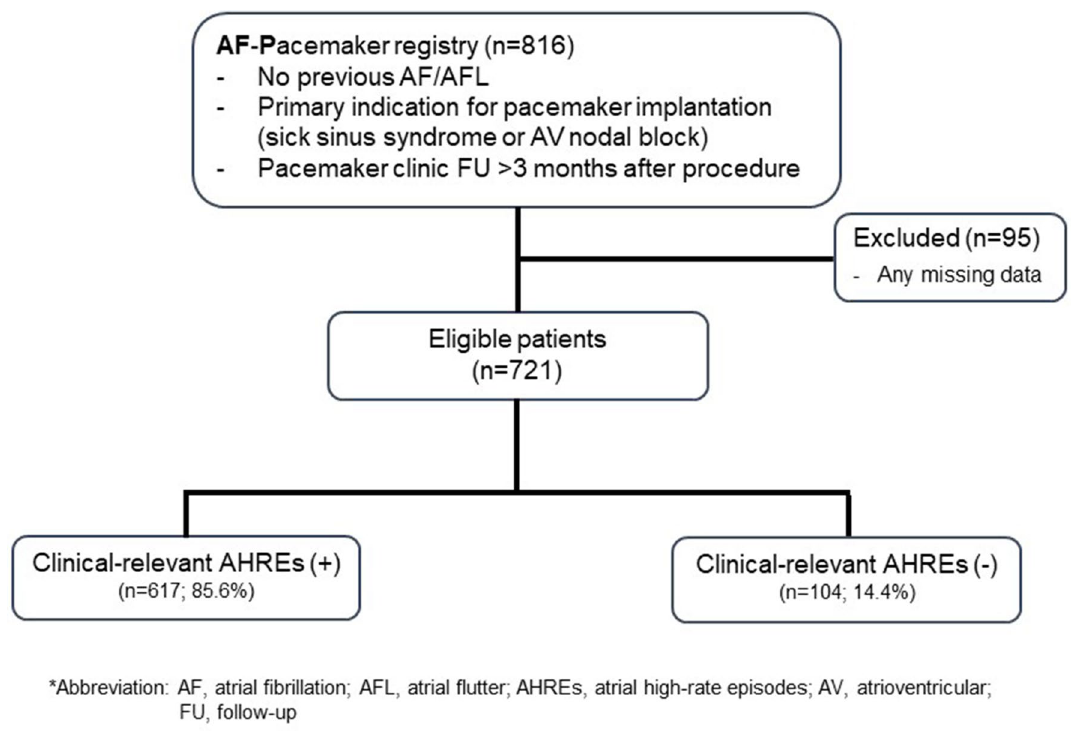
Figure 1. Study population selection